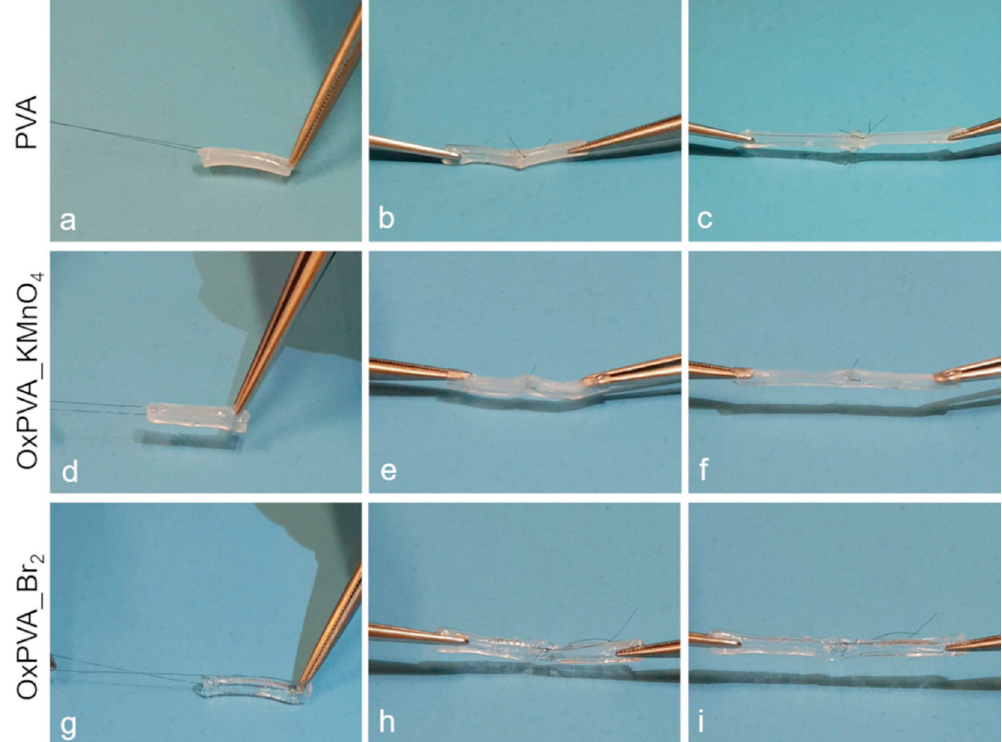
ff olds were tested for suture holding